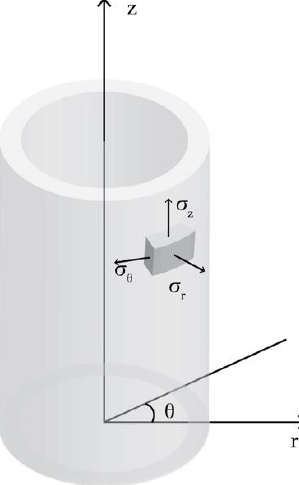
Figure 2. System of axes used for the positioning of specimens.